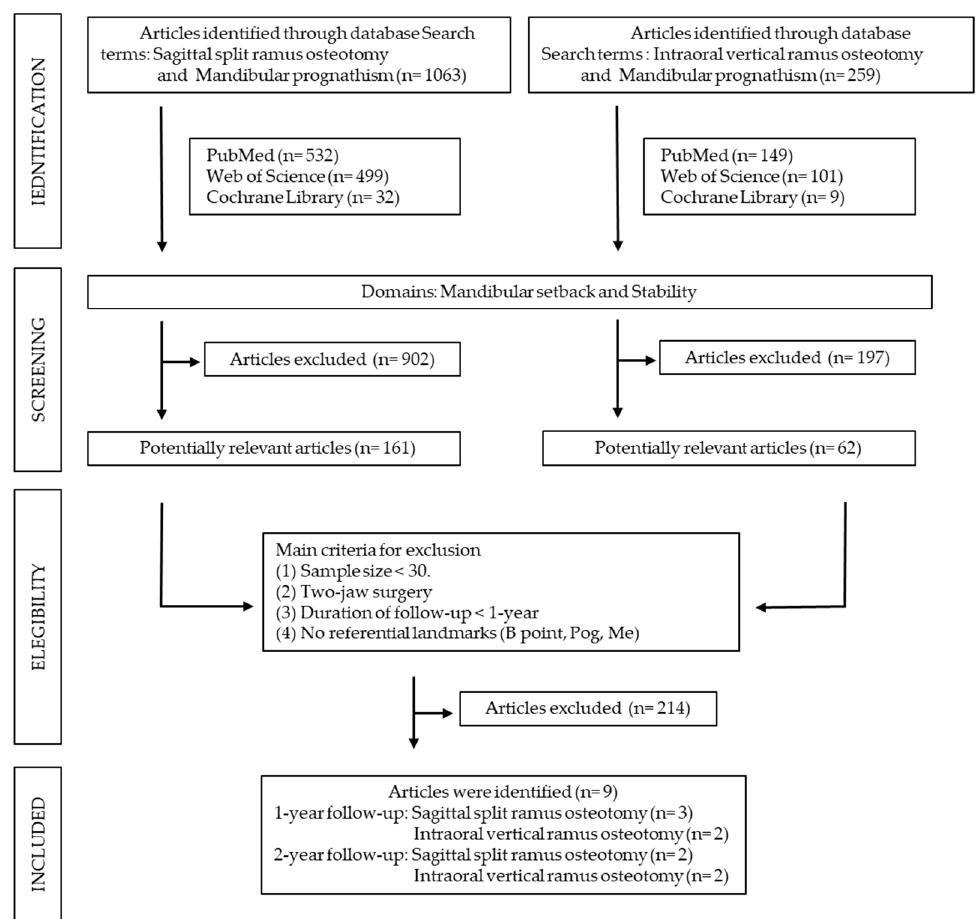
Figure 1. Process flow of article selection in sagittal split ramus osteotomy and intraoral vertical ramus osteotomy.